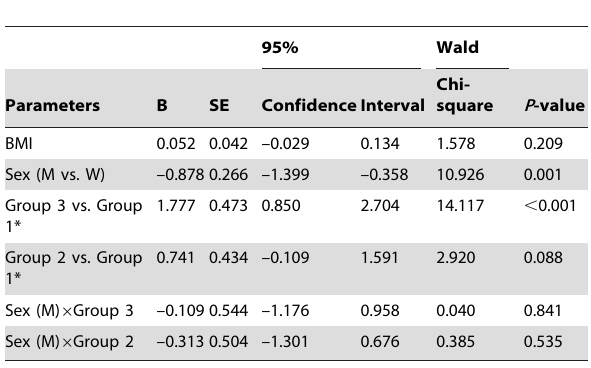
Table 4. Comparisons of meniscal T2 values among three age groups and two gender groups after adjusting for the BMI effect in multiple linear regression analysis with GEE.